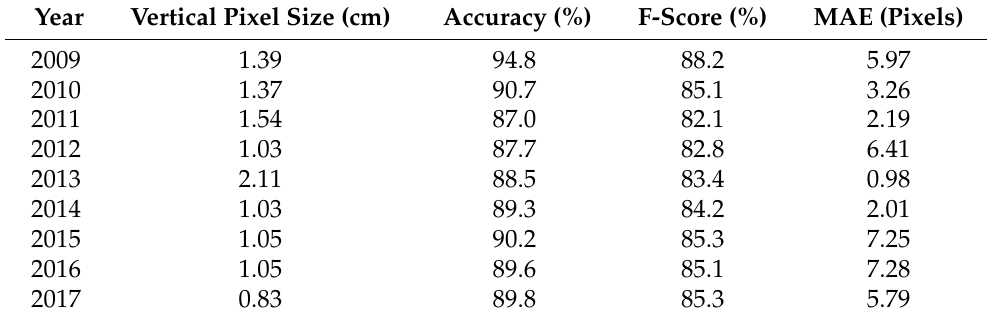
Table 6. Pixel size in the vertical (depth) direction, as well as the accuracy, F-score, and MAE, obtained over each year of